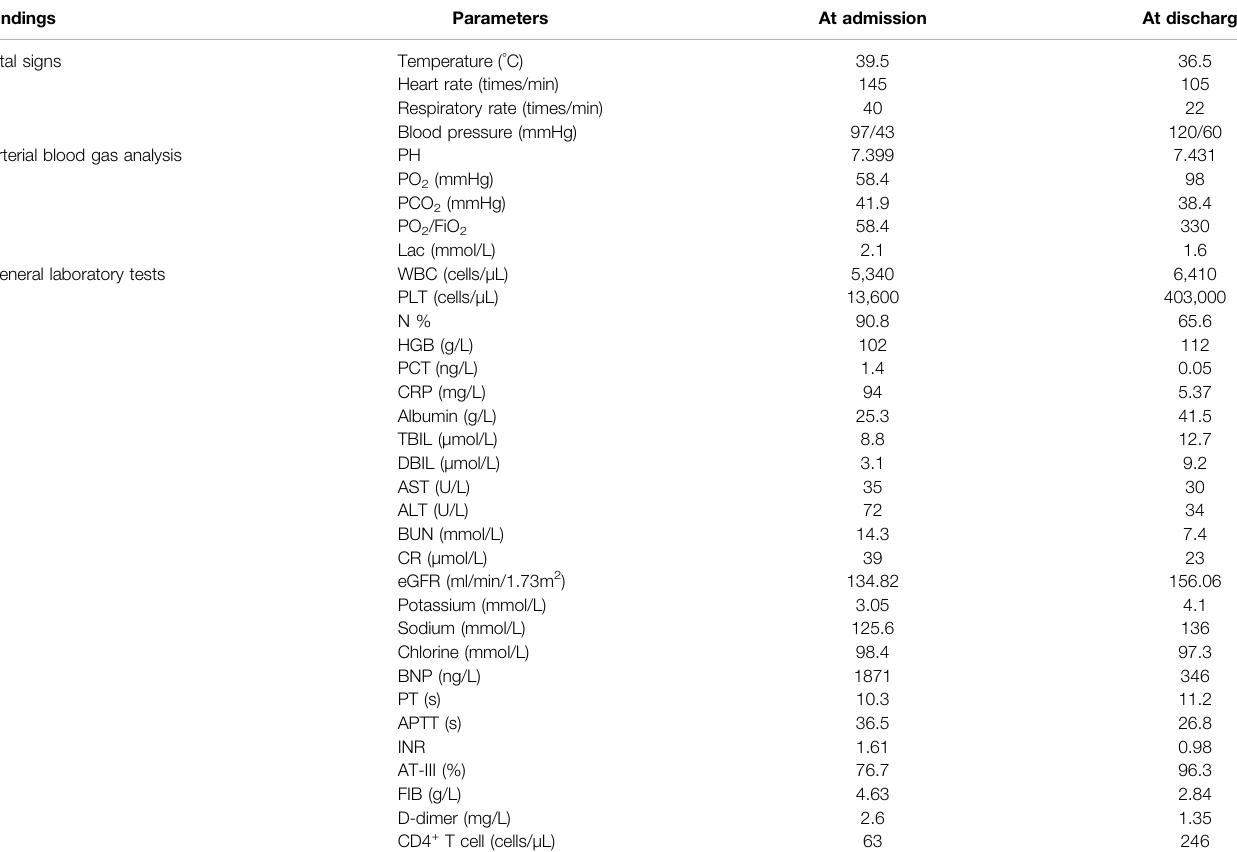
TABLE 1 | Findings from vital signs and laboratory tests at admission and discharge.